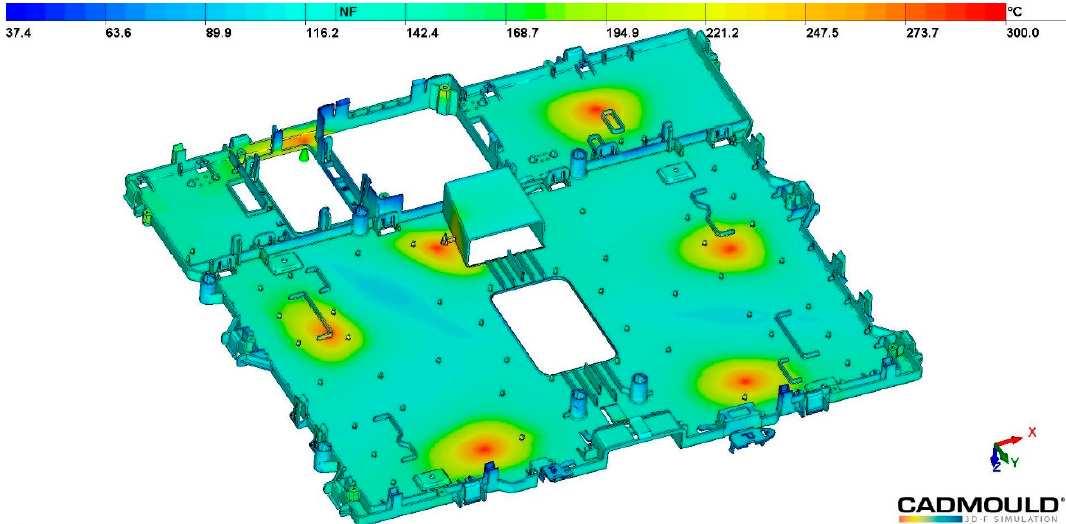
Figure 4. Temperature distribution on the sample at the ejection time.